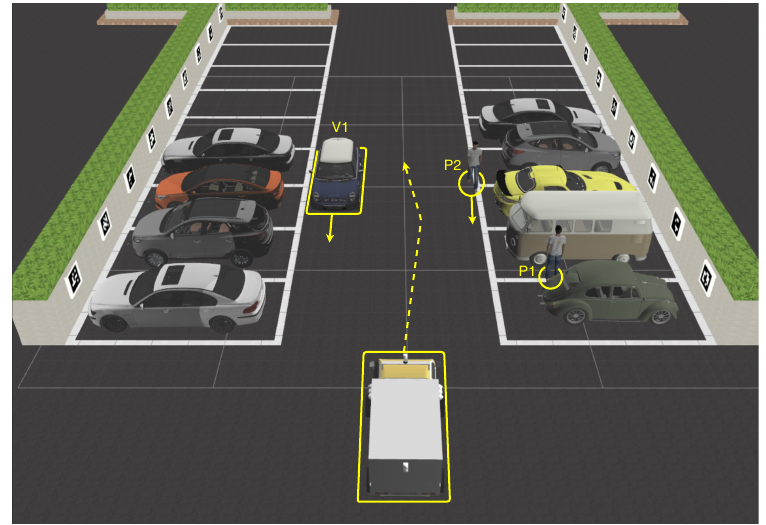
Figure 11. A driving scenario in